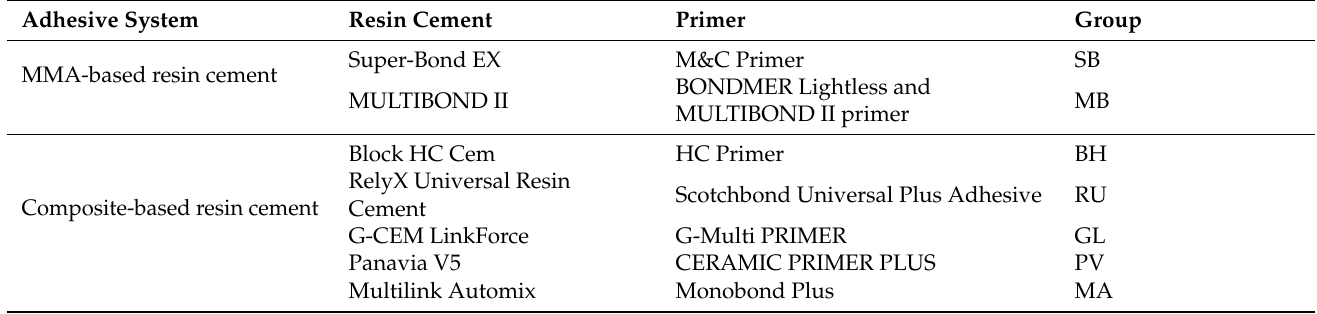
Figure 1. Flowchart of tensile bond strength test. Table 2. Combinations of the resin cements and primers used for PEEK bonding.